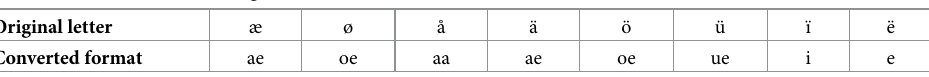
Table 2. Conversion of non-English